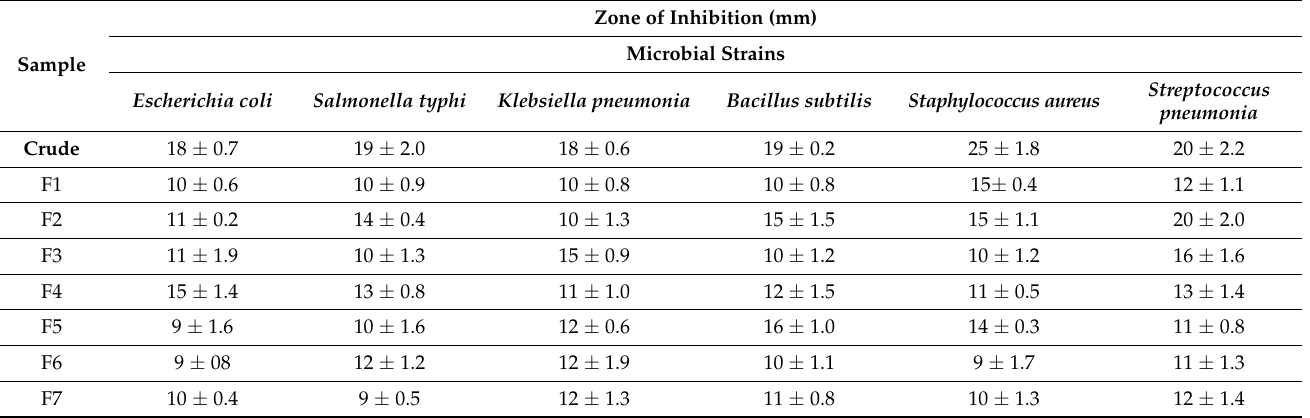
Table 4. Antibacterial activity of Met + Ext and purified fractions of Cydonia oblonga using agar well diffusion method.